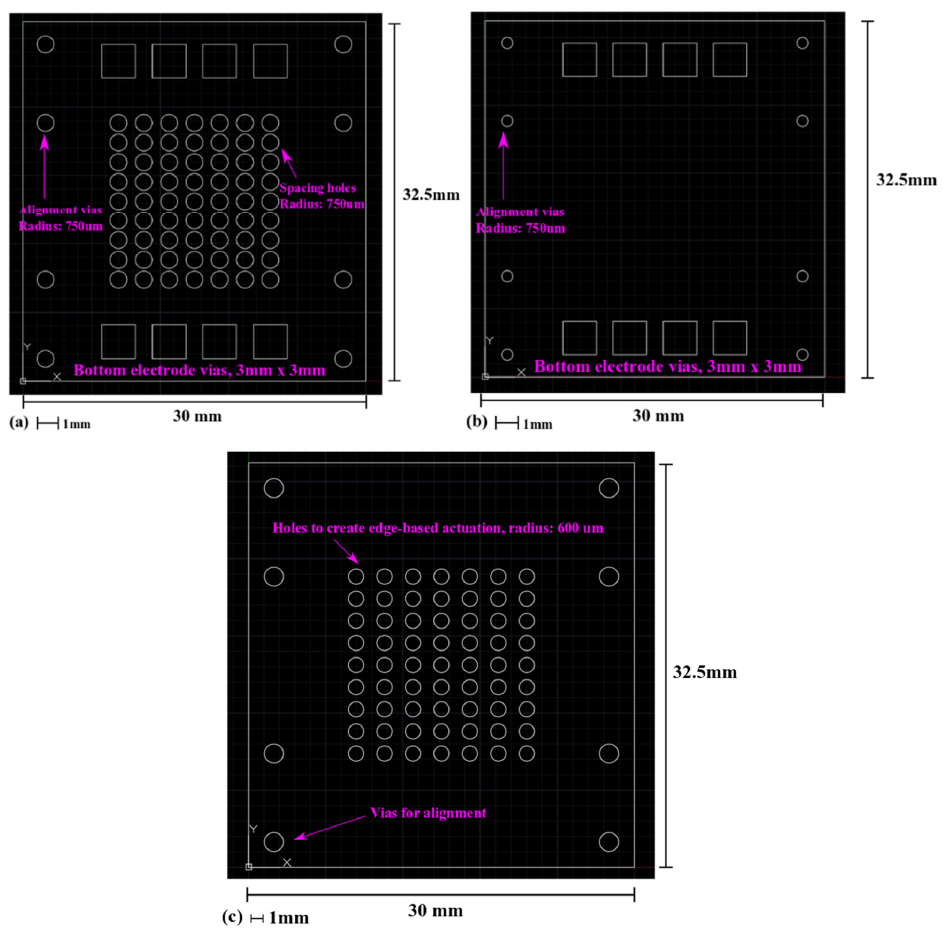
Figure 3. Mask designs for the laser micromachining processes of the polymeric piezoelectric MEMS devices for robustness test. ( a ) Polyimide spacer layer; ( b ) Polyimide structure layer; and ( c ) PVDF layer.